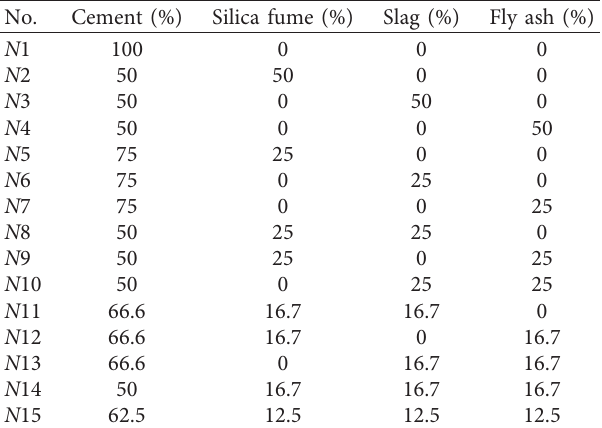
Table 2: Binder compositions of